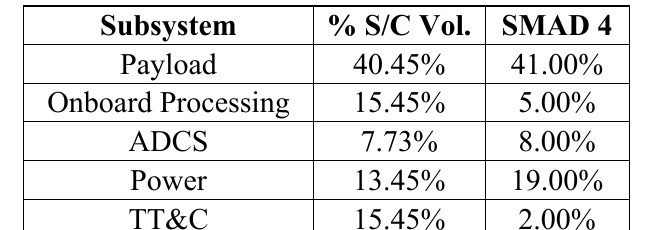
Table 6. Volume as a Percentage of Total Spacecraft Volume and comparison to SMAD 4 Values [11].